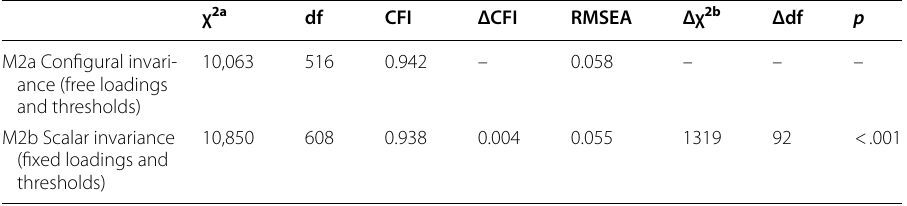
Table 8 Testing measurement invariance between Switzerland and Germany for ICT Usage